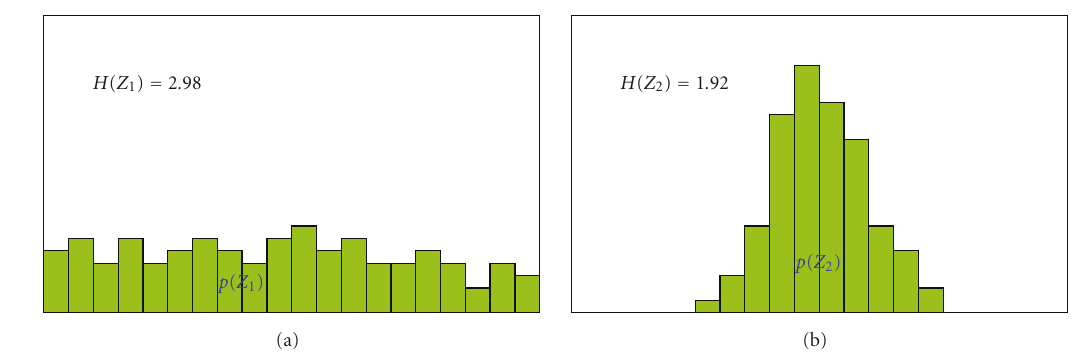
Figure 10: The information entropy. (a) Z 1 and (b) Z 2